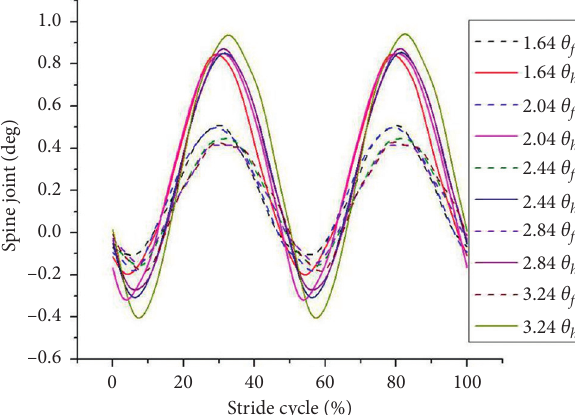
Figure 6: Motion of spinal joints at different